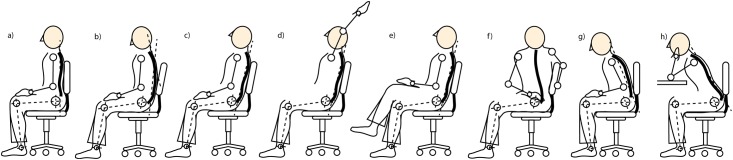
Sitting postures.a) Upright; b) Slump; c) Normal; d) ArmBackLeaning; e) RightOverLeft (or the opposite: LeftOverRight); f) TwistLeft (or the opposite: TwistRight); g) PokingChin; h) ArmLeaning.